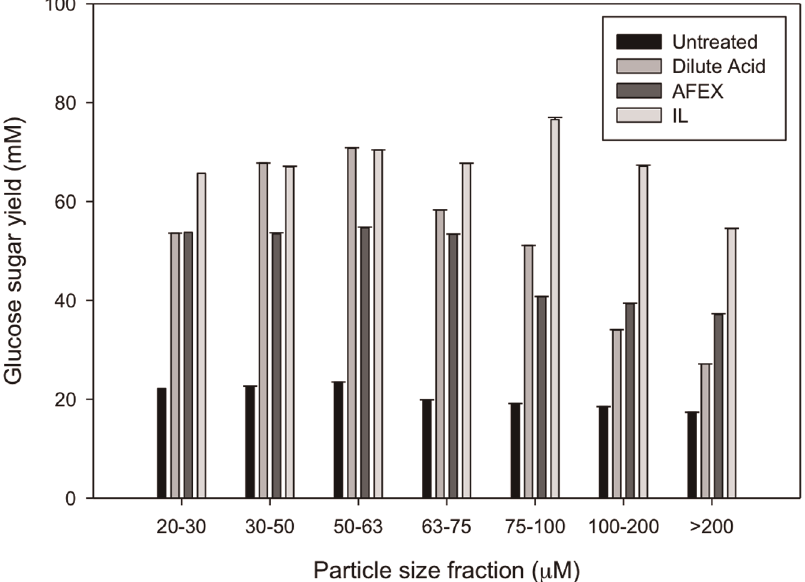
Figure 3. The yield of reducing sugar after enzymatic hydrolysis is shown for different particle size fractions for each pretreatment regime.